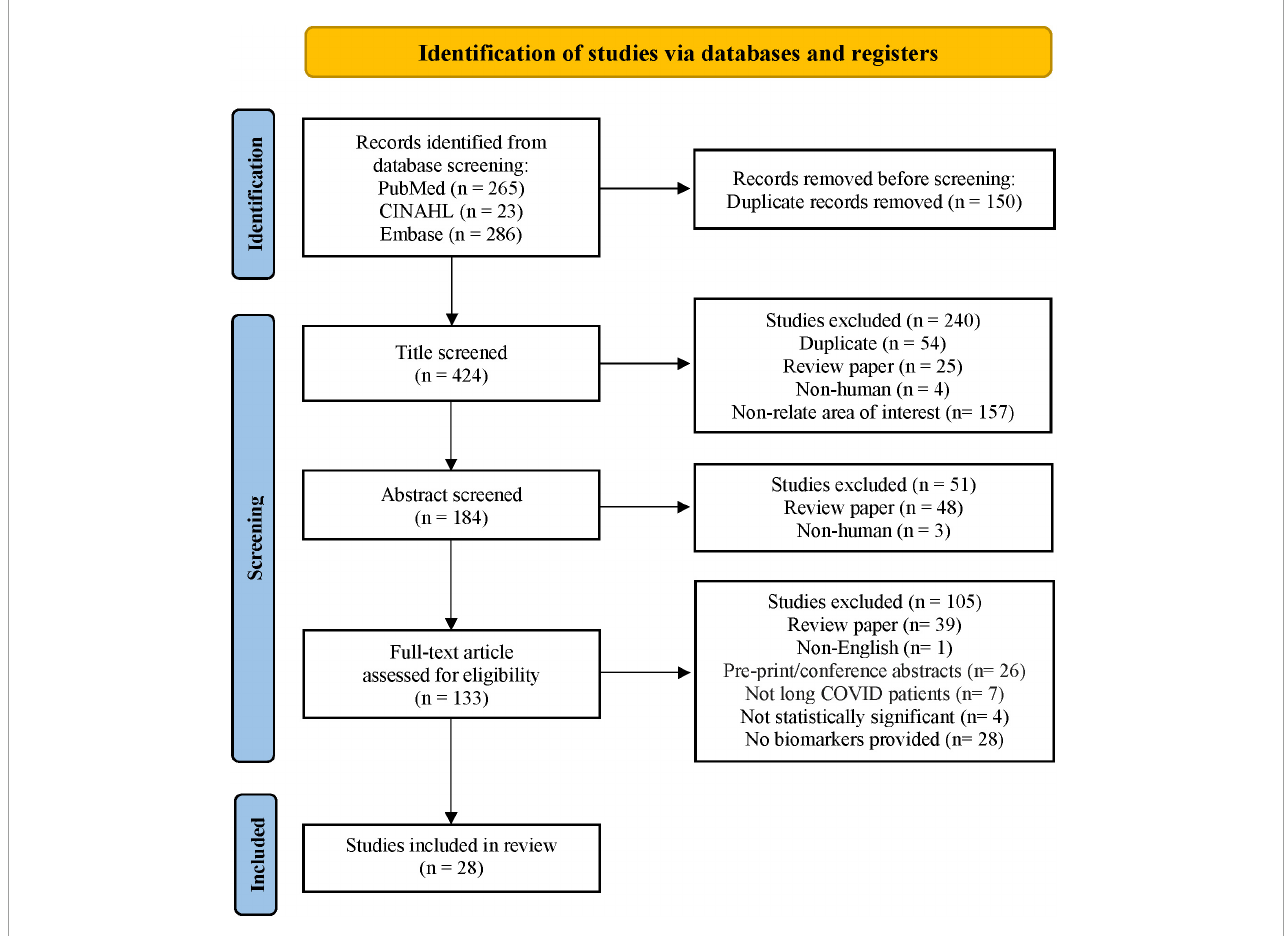
FIGURE1 Flow diagram of the literature search. Adapted from Page et al.